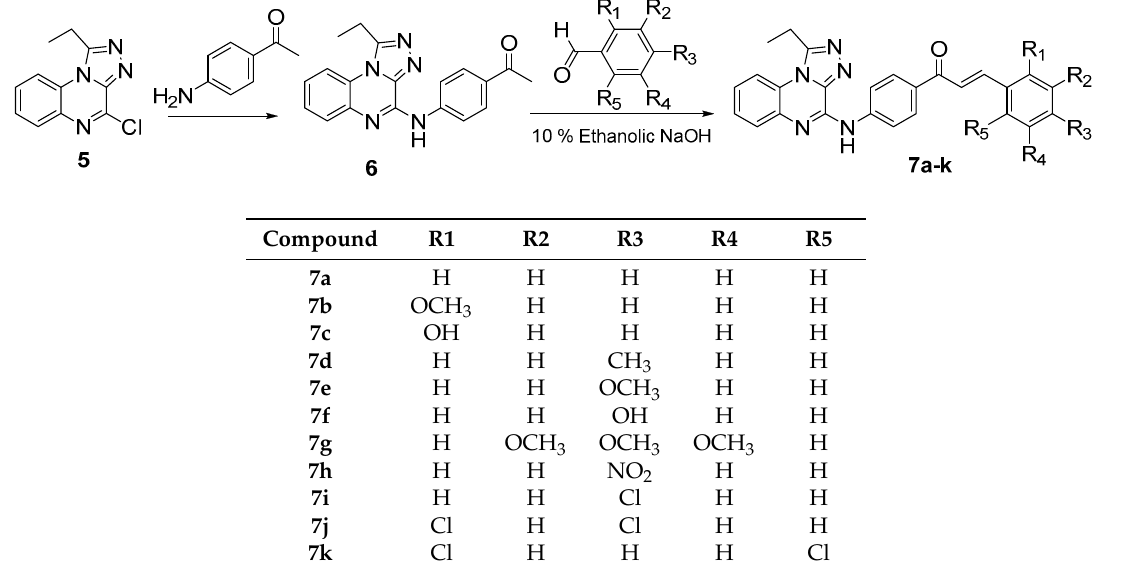
Table 1. Cytotoxicity screening of selected chalcone derivatives against three different cancer cell lines.